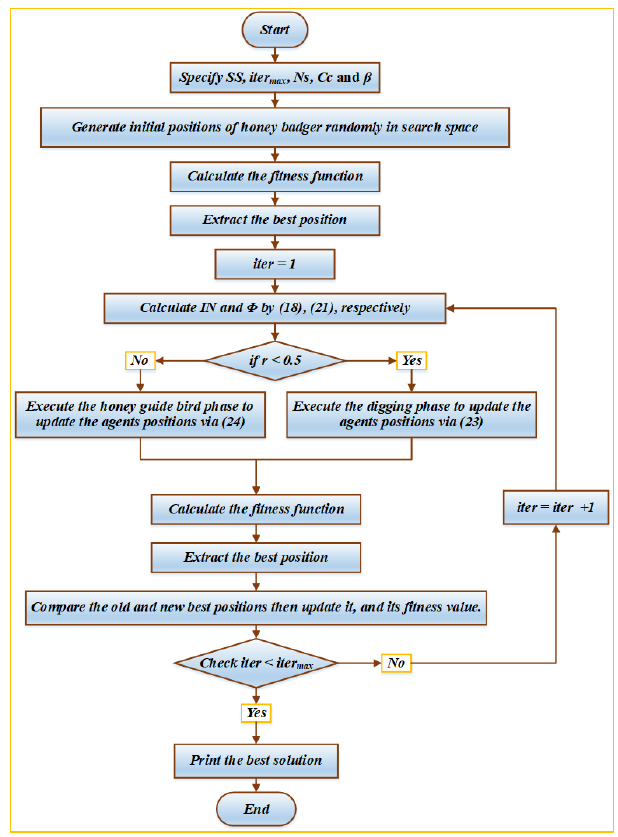
Figure 2. HBOA flowchart for the EDM integrating CHP units.